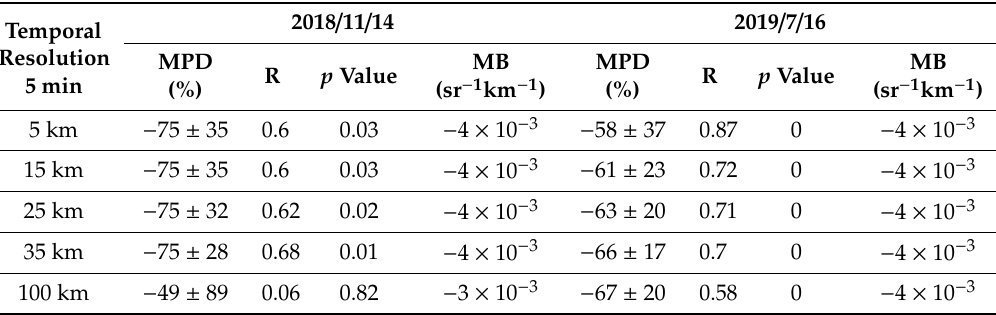
Table 1. Statistical results (mean percentage di ff erence (MPD), mean bias (MB), R, and p value) derived from simultaneous measurements between CALIOP and Mace Head data for a cloud–free case (18 / 11 / 14) and for a case with a thin cloud (19 / 07 / 16) considering di ff erent along–track averages in CALIOP data (5 km, 15 km, 25 km, 35 km, and 100 km). The results of the comparison considering di ff erent temporal averages in Mace Head data (30 min and 60 min) are presented in the Appendix